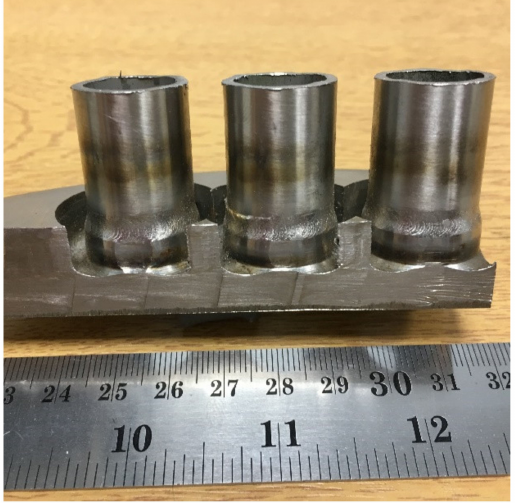
Figure 12. Example of tubes back face welded to a tube